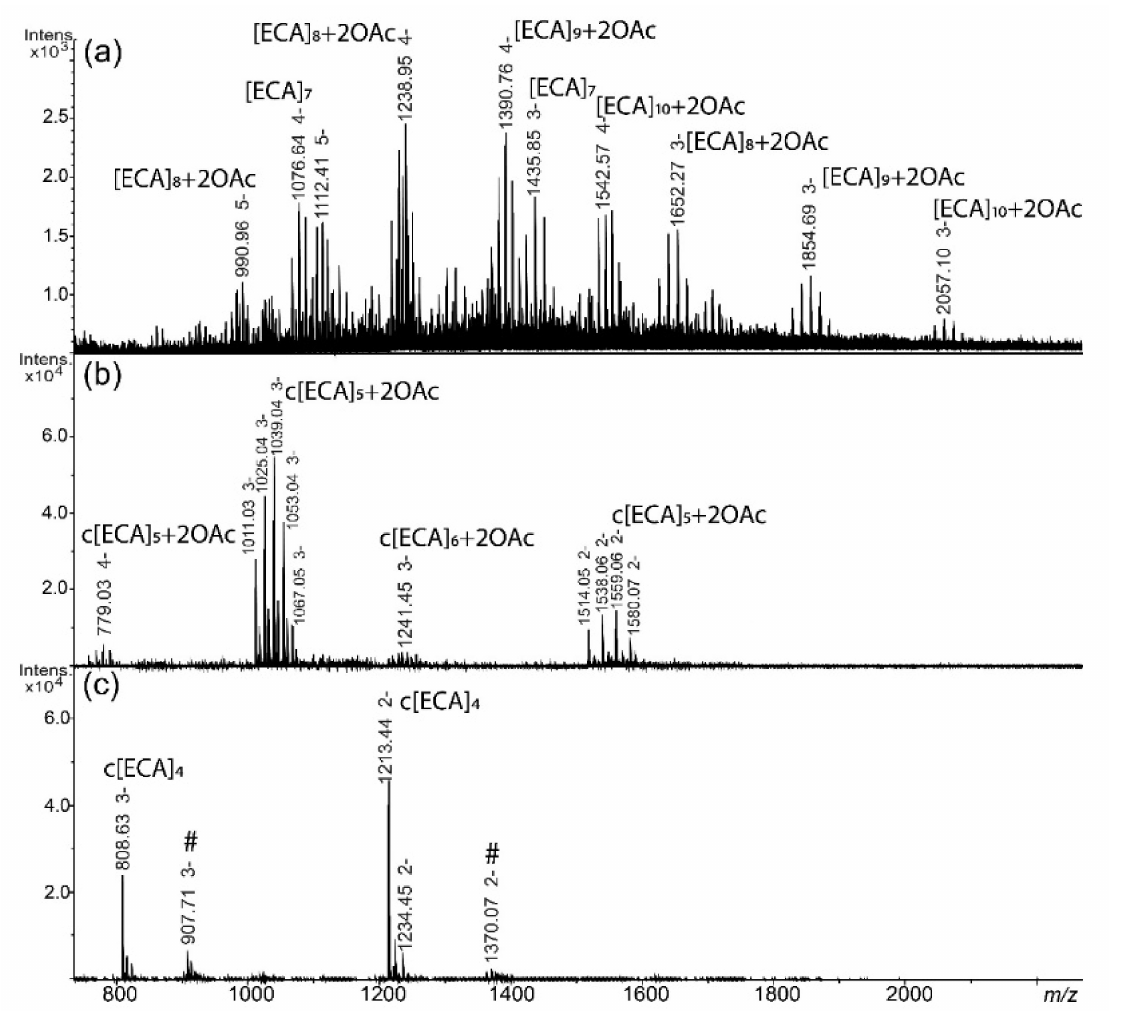
Figure 3. ESI-MS spectra of ECA forms obtained from E. coli R1 lipopolysaccharide (LPS) supernatant acquired in negative- ion mode for ( a ) fraction I; ( b ) fraction II; and ( c ) fraction III. [ECA], trisaccharide repeating unit of ECA: → 3)- α -D-Fuc p 4NAc- (1 → 4)- β -D-Man p NAcA-(1 → 4)- α -D-Glc p NAc-(1 → present as constituent of linear [ECA] n or cyclic form of ECA c[ECA] n ; OAc— O -acetyl group. Arabic numerals indicate charge of the ion; #—non-interpreted